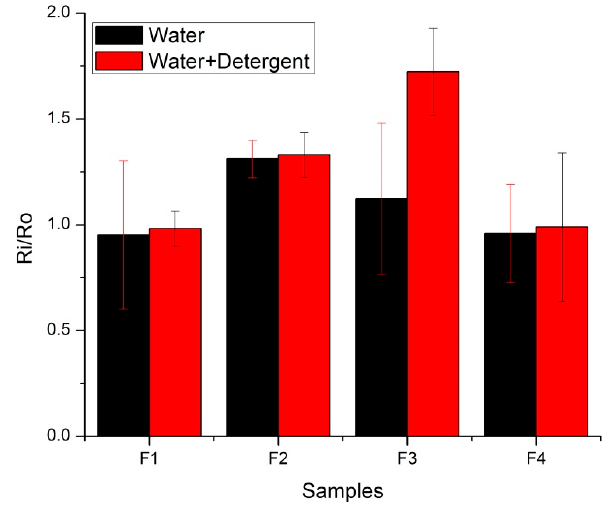
Figure 16. Surface resistance analysis with immersion in solutions (F1–F4 electrodes).